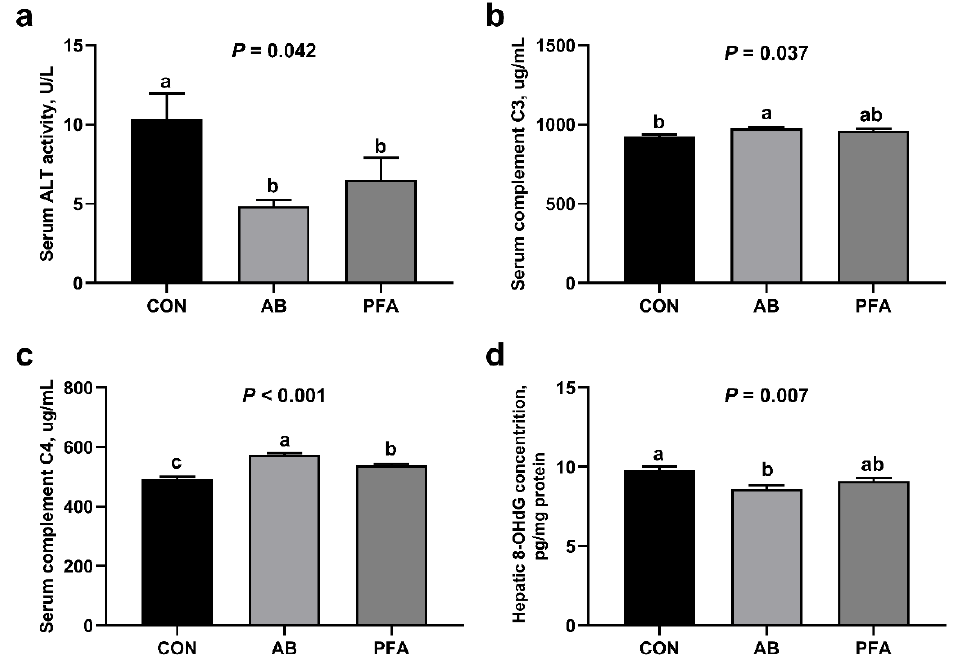
Figure 2. Effects of paraformic acid (PFA) supplementation on hepatic injury indexes in broiler chickens. ( a ) Alanine transaminase (ALT); ( b ) Complement C3; ( c ) Complement C4; ( d ) 8-OHdG, 8-hydroxy-2’-deoxyguanosine. CON, broiler chickens receiving basal diet; AB, broiler chickens receiving basal diet supplemented with 50 mg/kg aureomycin; PFA, broiler chickens receiving basal diet supplemented with 1000 mg/kg PFA. Values are mean ± standard error ( n = 7). a,b,c Means with different superscripts differ ( p <